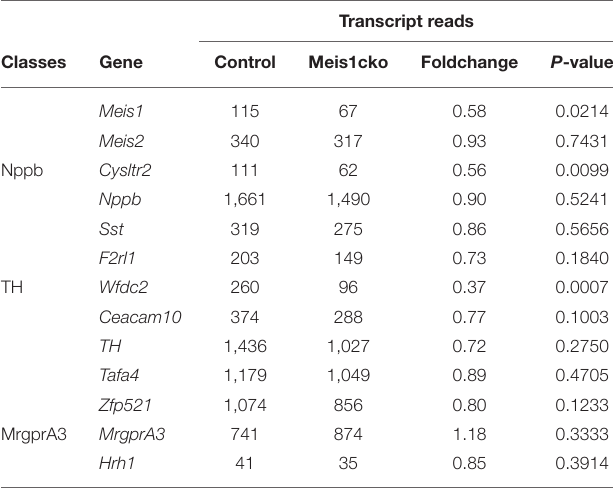
TABLE 2 | Microarray analysis showing the transcript reads of a subset of cluster-specific marker